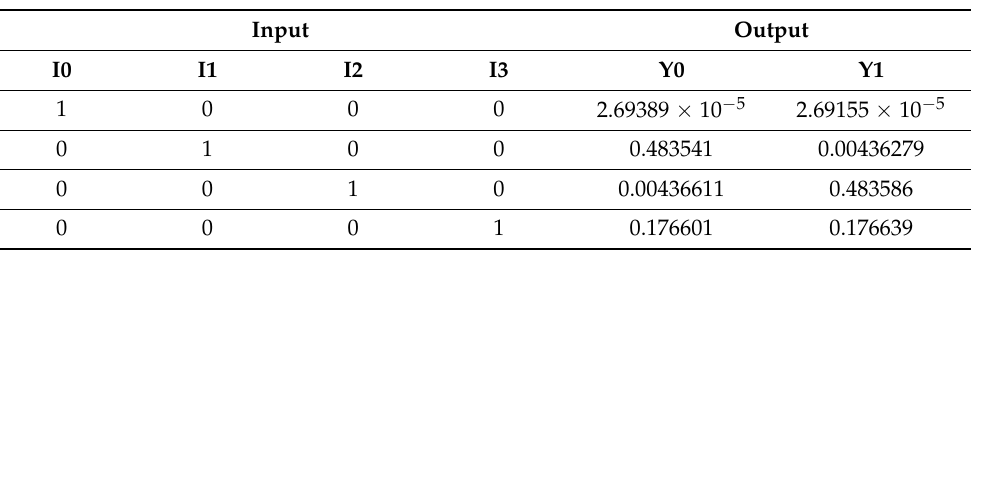
Table 3. Normalized transmission under different coding